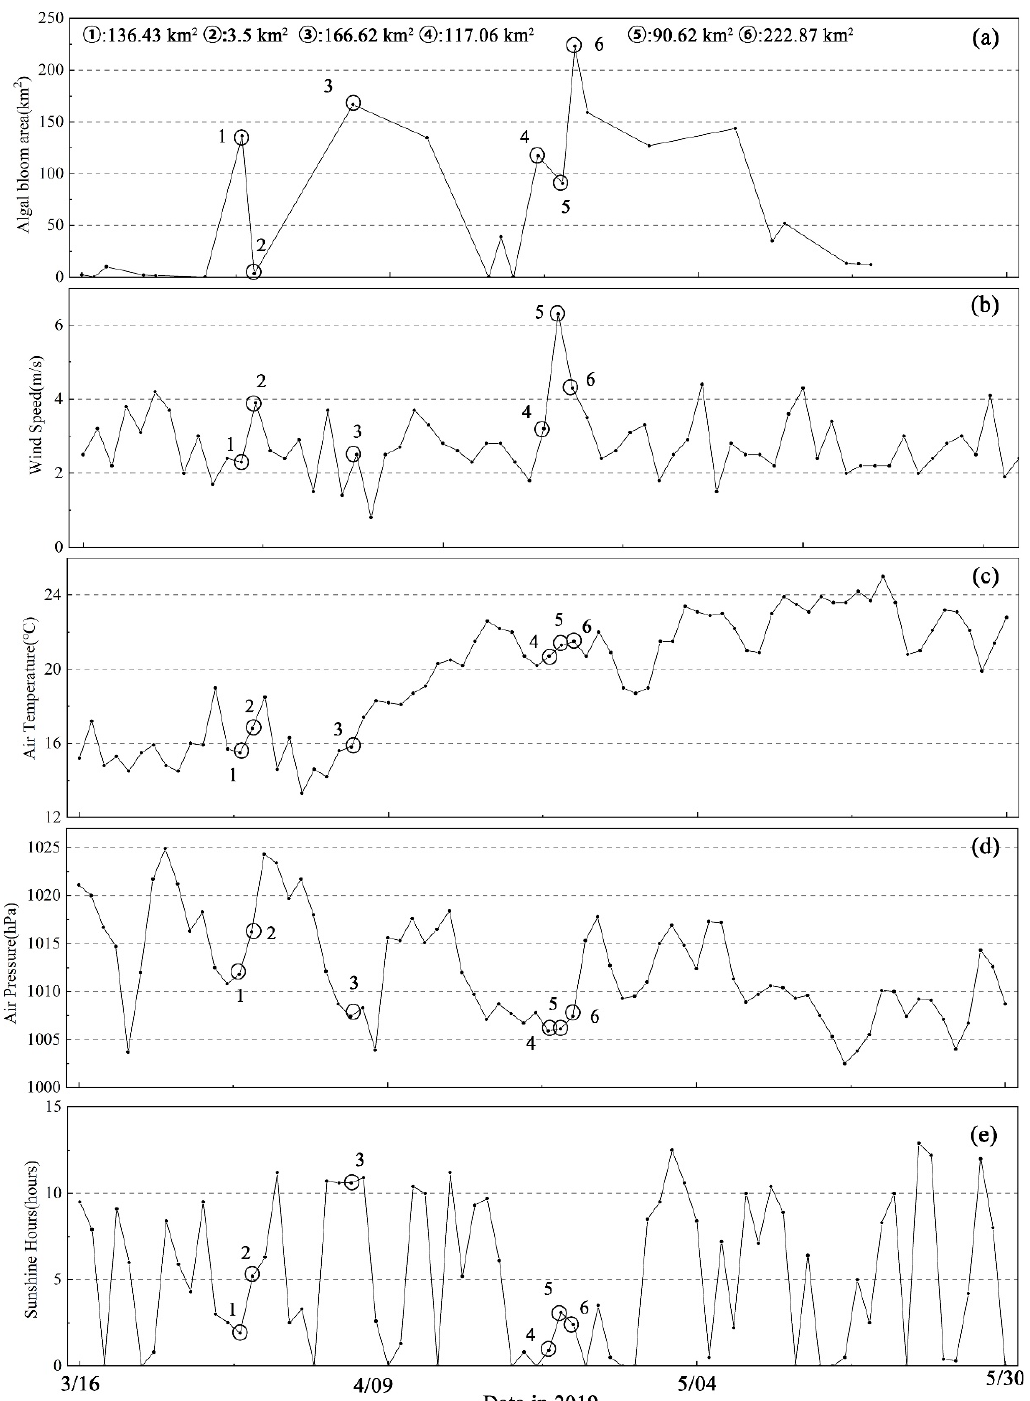
Figure 11. Algal bloom area, wind speed, air temperature, air pressure, and sunshine hours. The black solid circles in ( a ) represent the bloom areas derived from MODIS/Terra data. ( b ) Mean daily wind speed, ( c ) mean daily air temperature, ( d ) mean daily air pressure, and ( e ) mean daily sunshine hours. The numbered circles represent the 6 days during which the algal bloom areas changed greatly due to strong winds that triggered the dissipation of algal blooms on the water surface at Lake Dianchi.